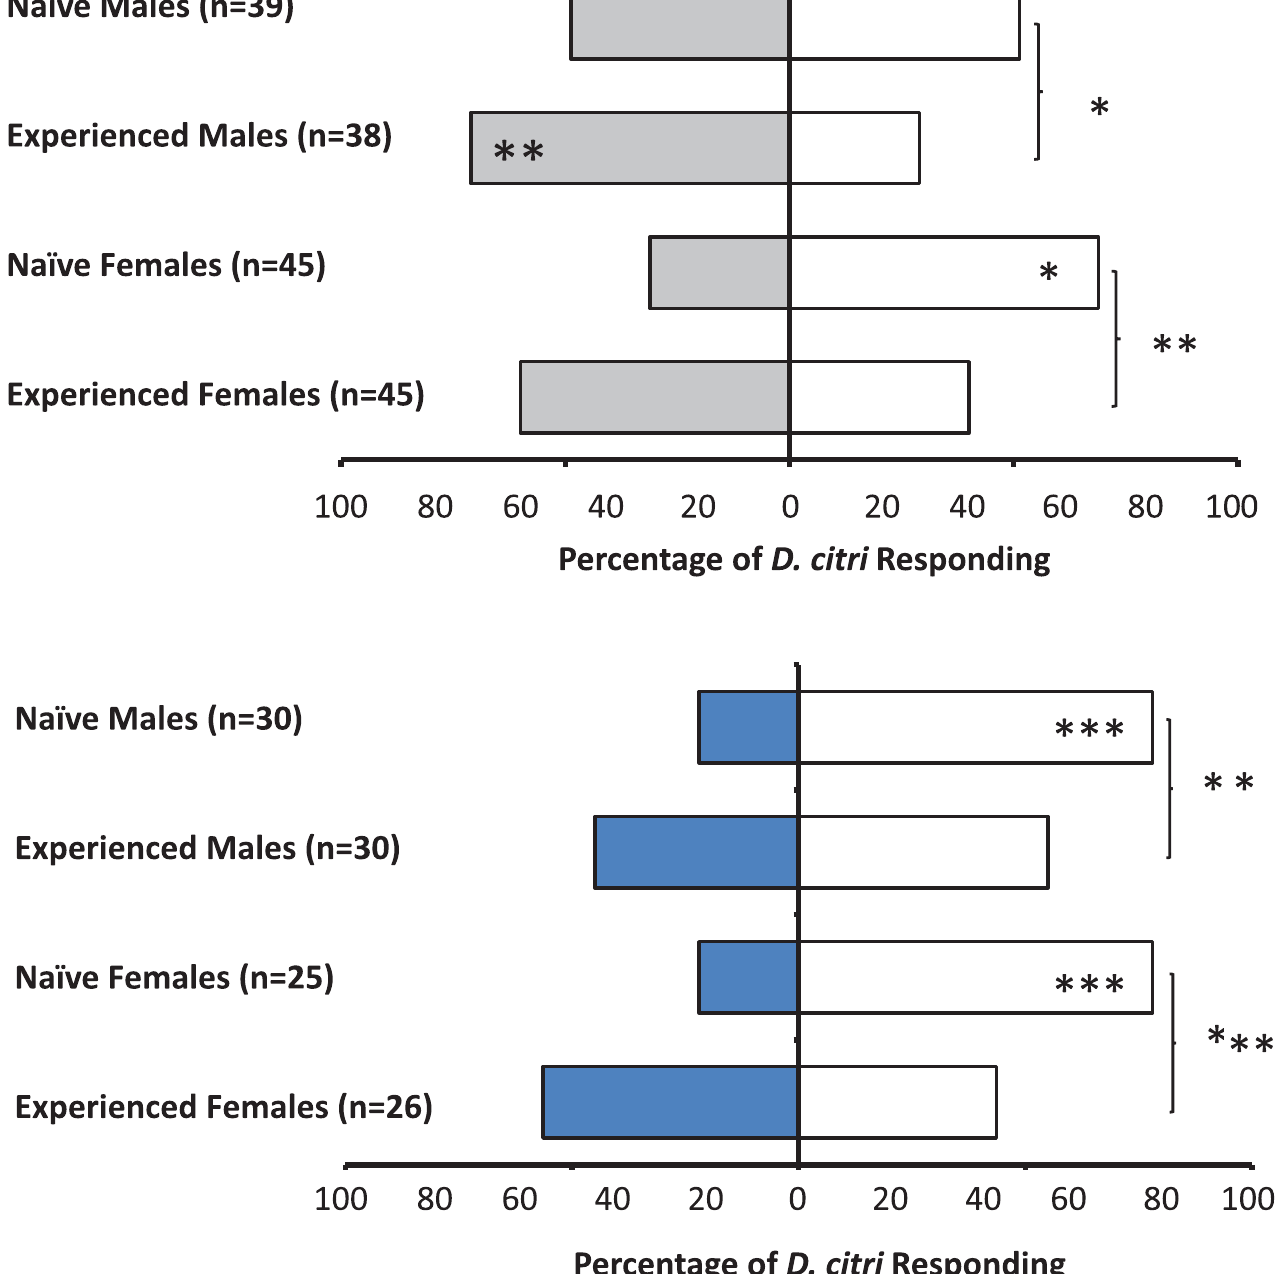
PLOS ONE | DOI:10.1371/journal.pone.0149815 March 1, 2016 10 /